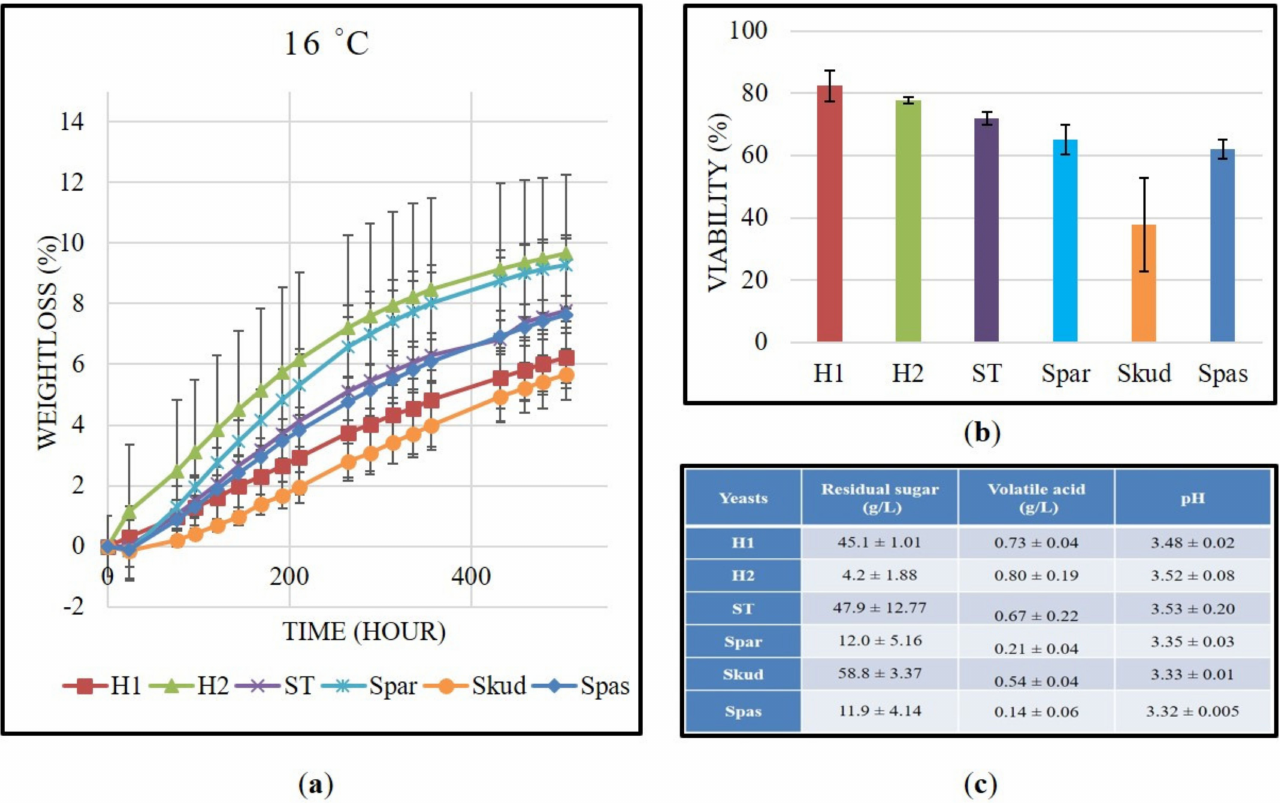
Figure 5. Fermentation progress ( a ) and viability of the investigated strains at the end of the fermen- tation ( b ) at 16 ◦ C and analytical parameters of the fermented must ( c ). H1, H2: isolates